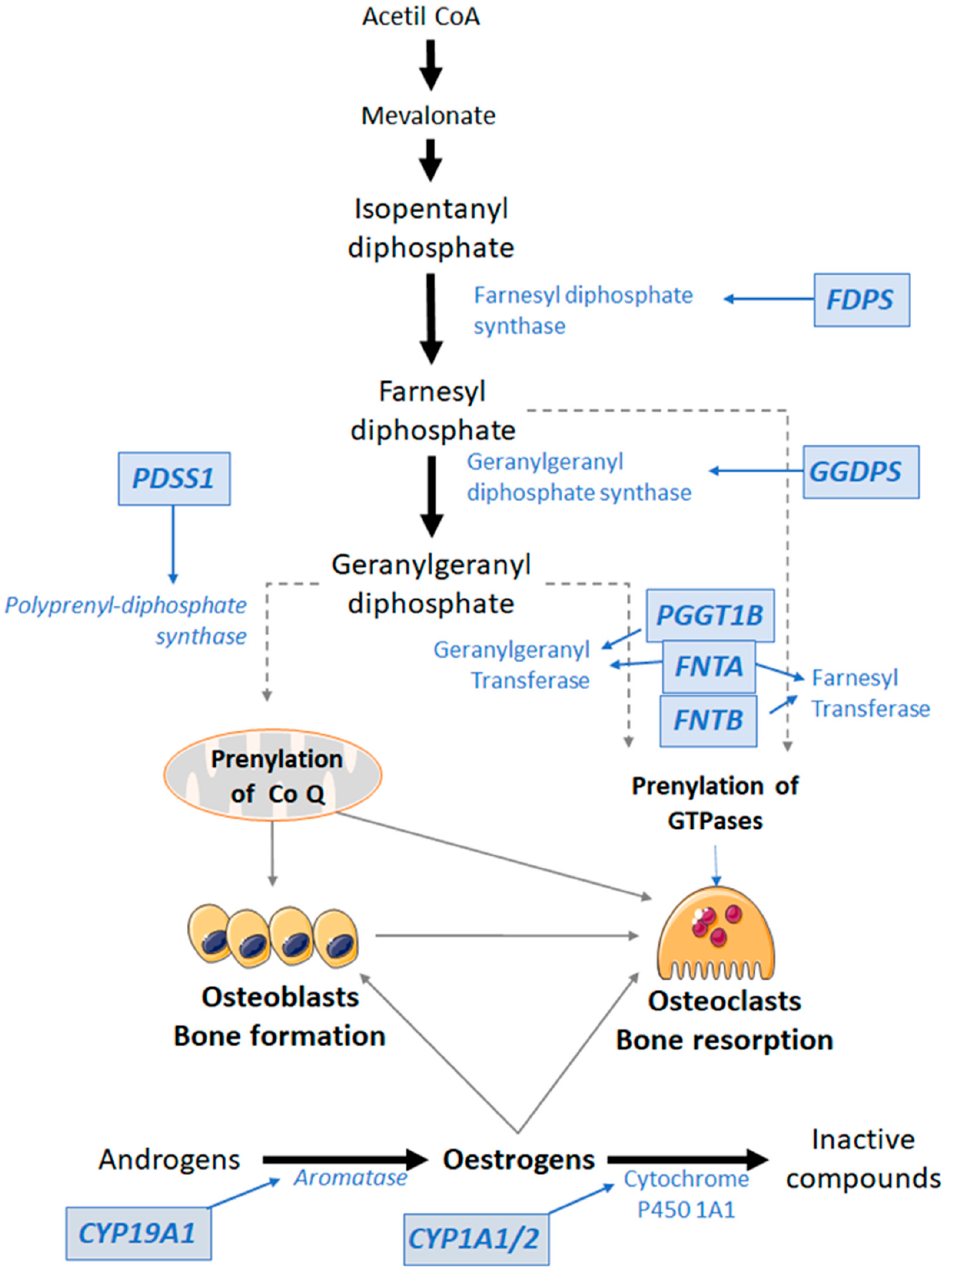
Figure 8. Genes and enzymes associated with antiresorptive drug response in the present study and their relationship with osteoblast and osteoclast